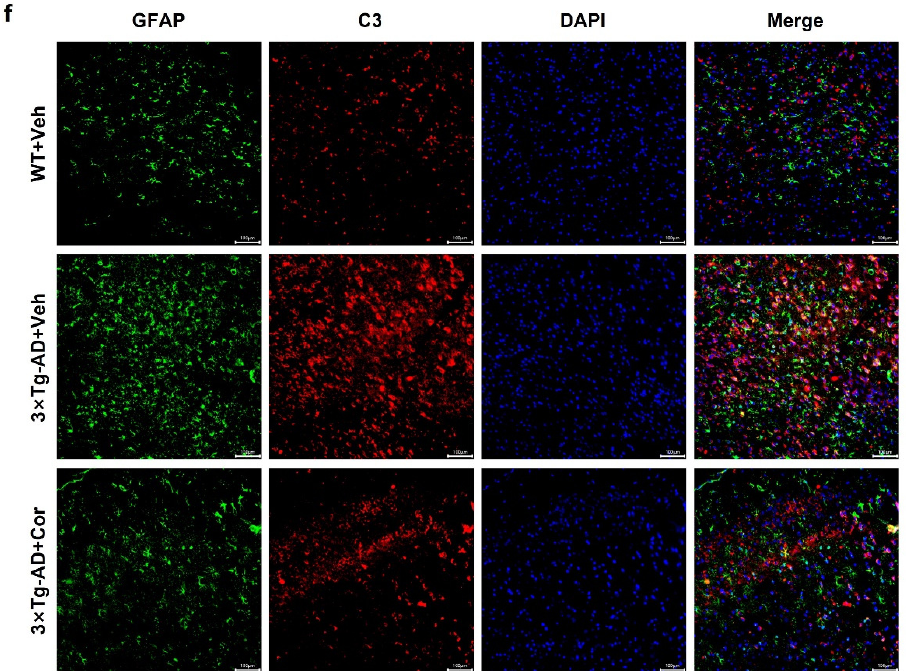
Figure 4. Cornuside-regulated A1/A2 astrocytic phenotype alteration in 3 × Tg-AD mice. ( a ) The mRNA expression of the A1 astrocyte markers Psmb8, Serping1, C3, Amigo2, and Gbp2 in 3 × Tg-AD mice in the presence or absence of cornuside compared to WT control mice ( n = 5 per group). ( b ) The mRNA expression of the A2 astrocyte markers Ptx3, S100A10, Tgm1, Ptgs2, and CD14 in 3 × Tg-AD mice in the presence or absence of cornuside compared to WT control mice ( n = 5 per group). ( c ) The representative images and ( d , e ) quantification analysis of C3 protein (A1 astrocyte marker) and S100A10 protein (A2 astrocyte marker) in the hippocampi and cortices of 3 × Tg-AD mice with or without cornuside treatment compared with WT control mice ( n = 6 per group). ( f ) Representative immunofluorescent micrographs indicating the C3 and GFAP co-localization in astrocytes in the cortex. Scale bar = 100 µ m. Data presented are mean ± SEM. # p < 0.05 and ## p < 0.01 compared with WT + Veh; * p < 0.05 and ** p < 0.01 compared with 3 × Tg-AD + Veh